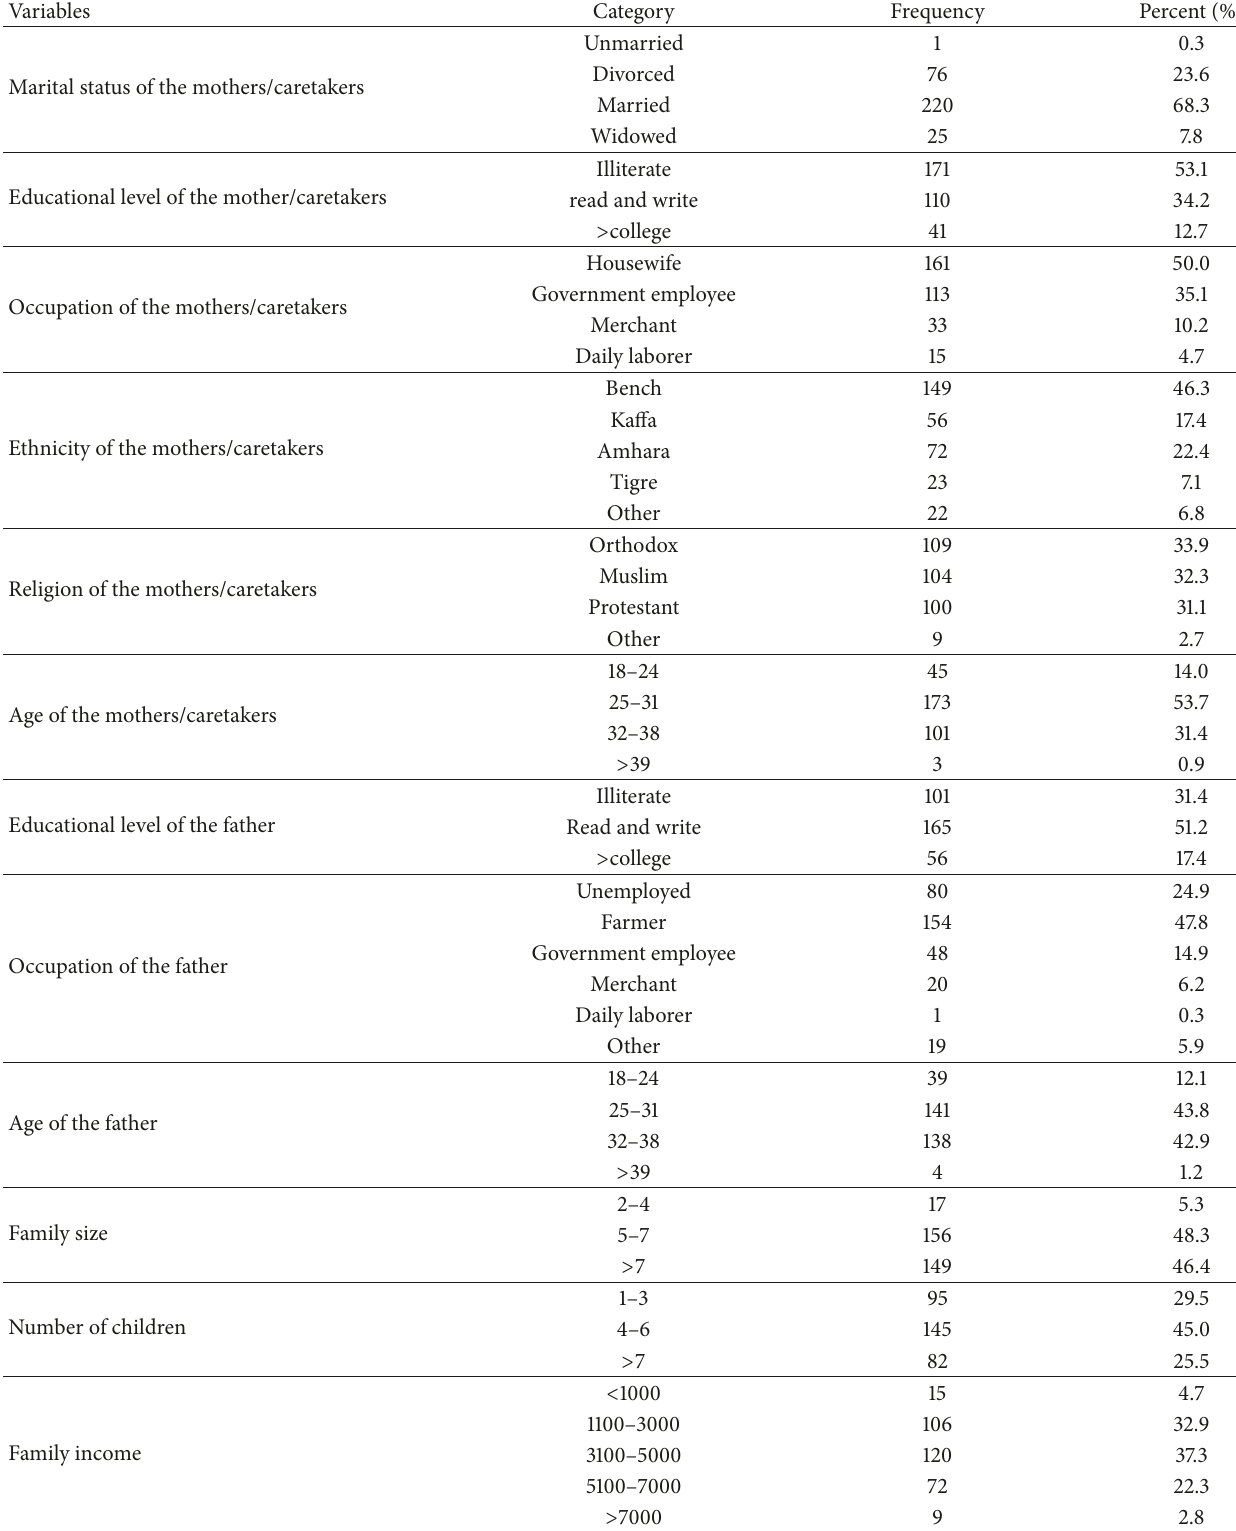
Table 1: Sociodemographic characteristics of the respondents at Mizan Aman town, Bench Maji zone, Southwest Ethiopia,